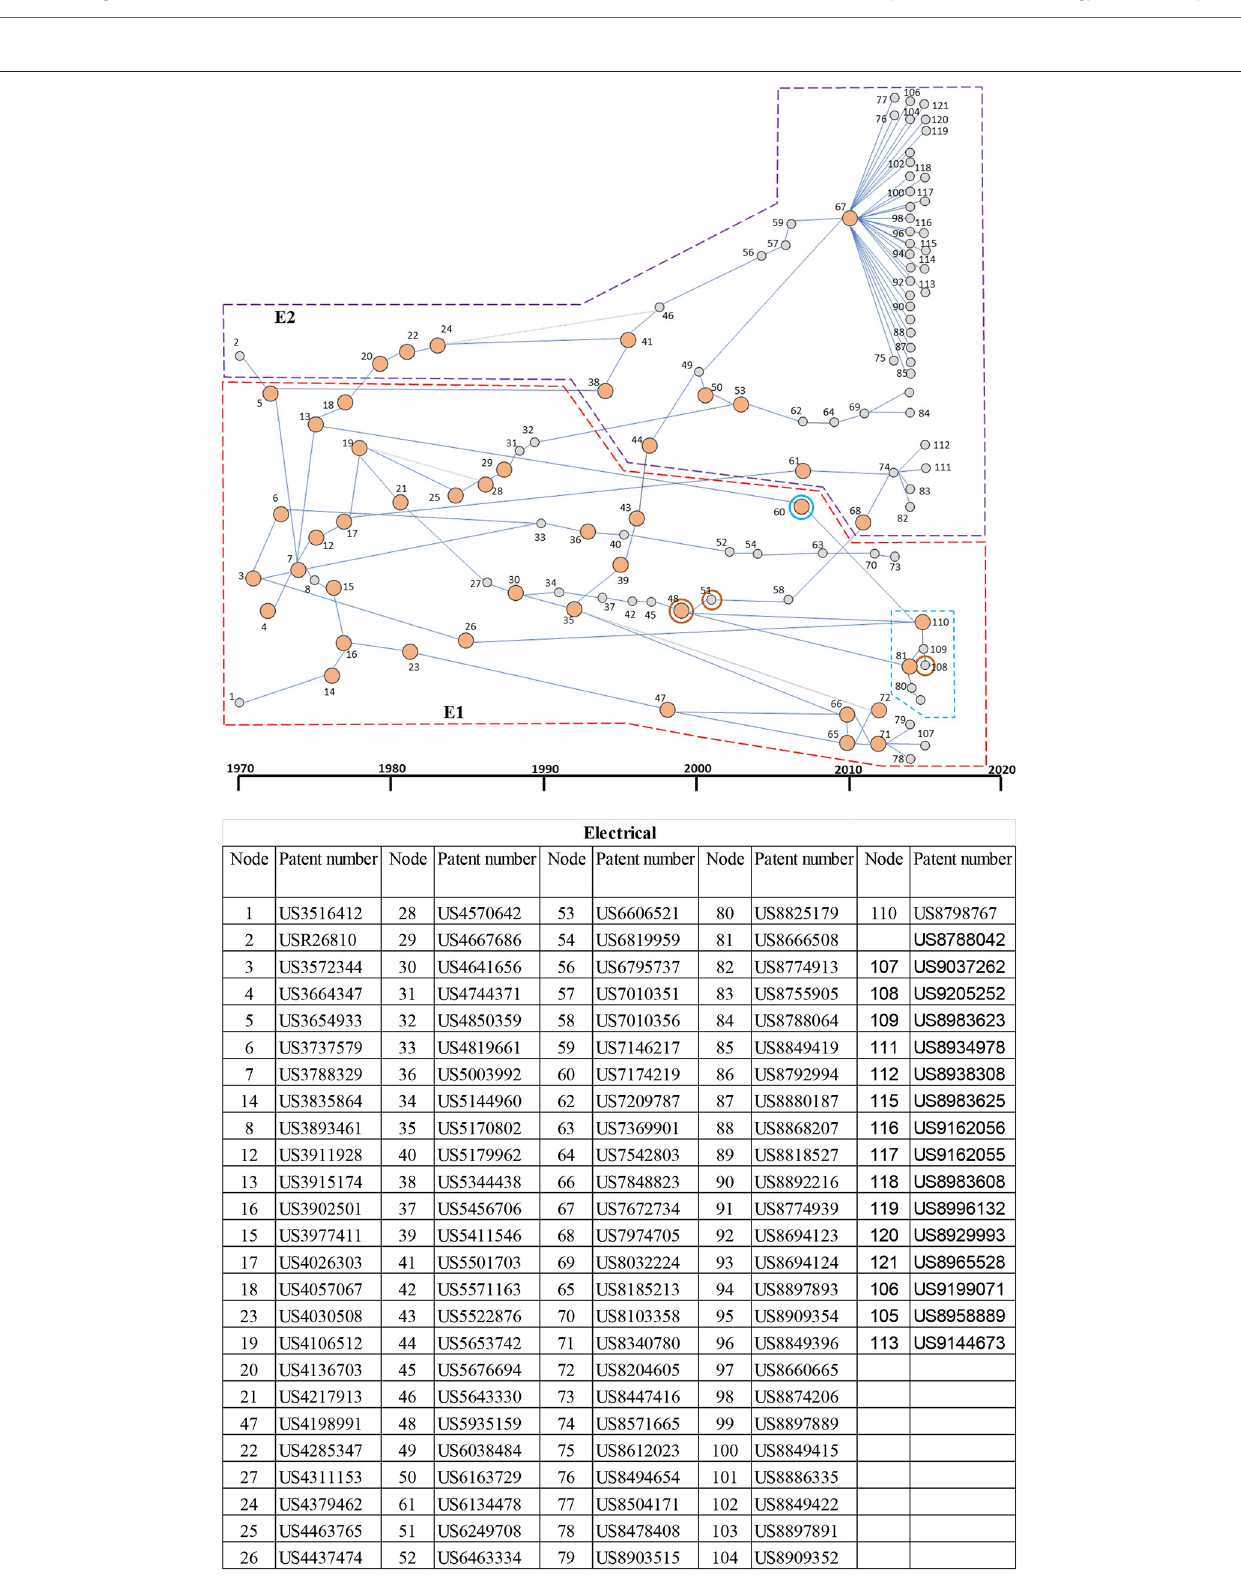
Frontiers in Medical Technology |